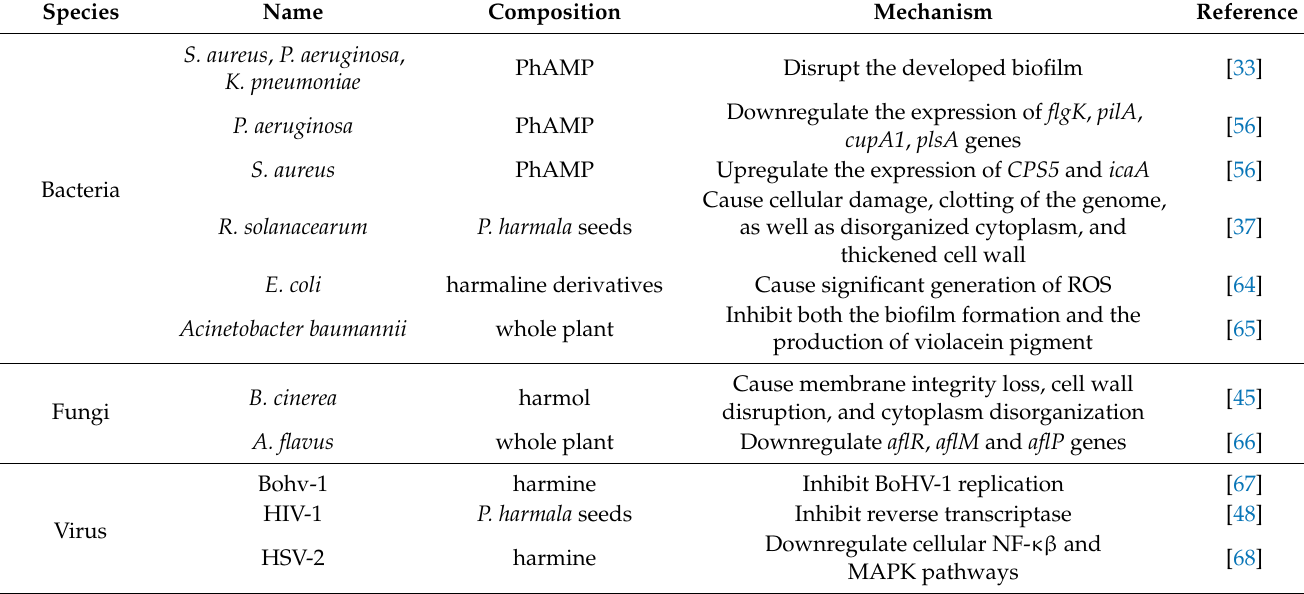
Table 1. The antimicrobial mechanism of P. harmala